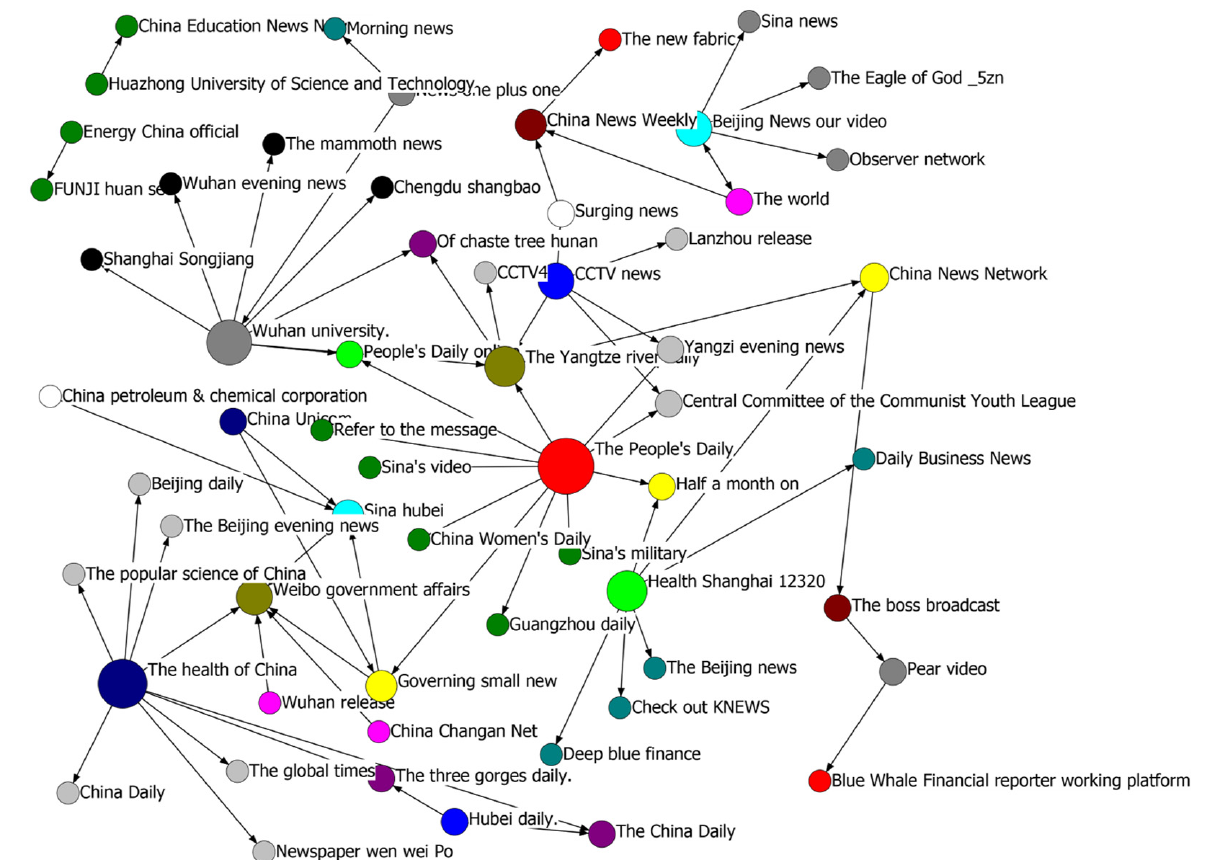
Figure 9. Analysis of the centrality of communication subjects.